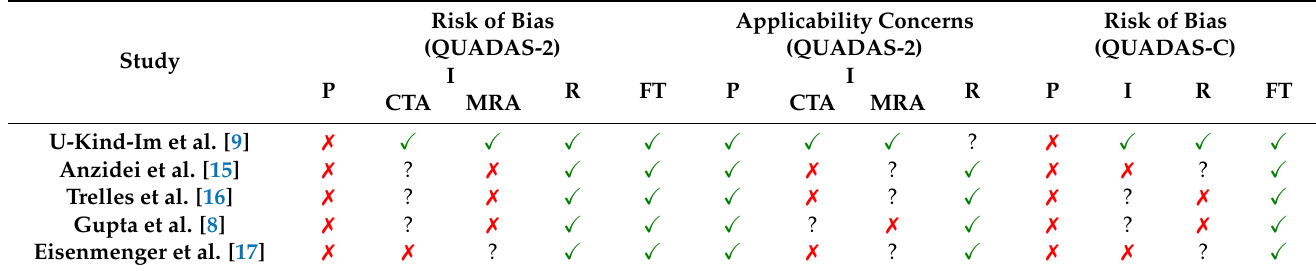
Table 5. QUADAS-2 and QUADAS-C tools. QUADAS-2 and QUADAS-C evaluation for each included